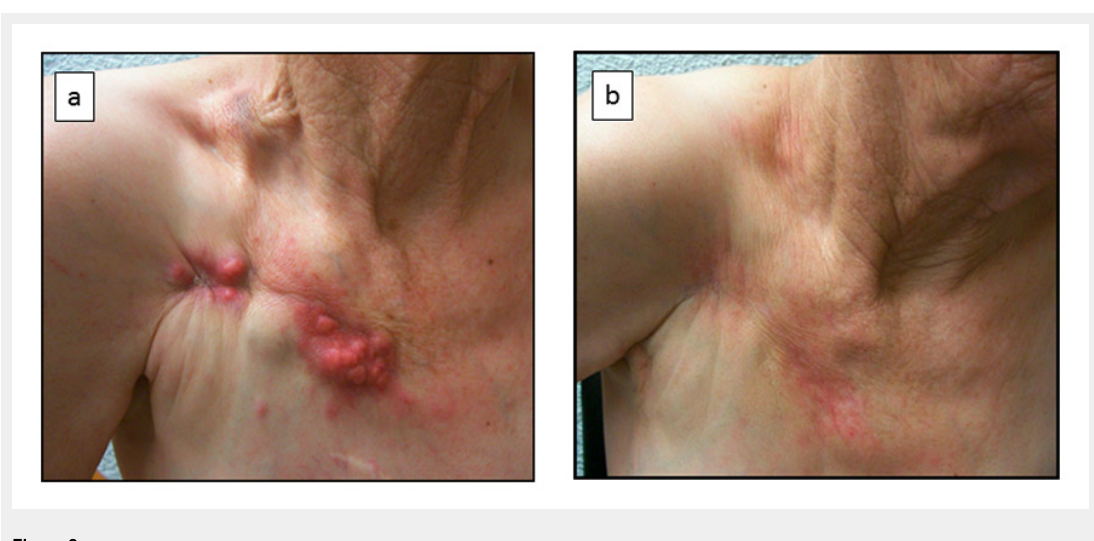
(a) Patient with isolated chest wall recurrence. (b) Complete locoregional response was achieved and sustained after reirradiation and hyperthermia at 2 years after the